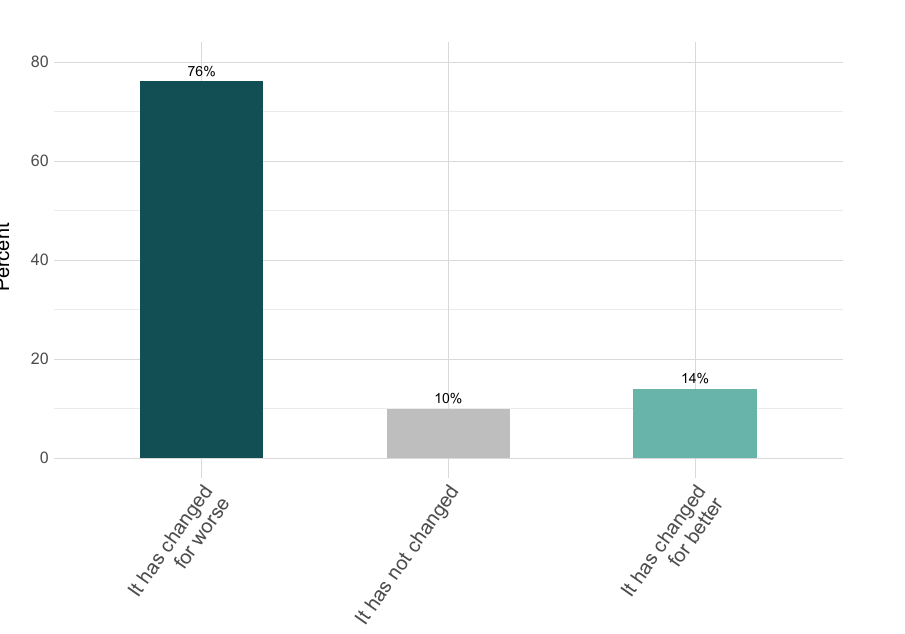
Figure 4. Overall satisfaction with the PhD training before and during the pandemic. Answers including “very” and “somewhat” for both “satisfied” and “dissatisfied” were collapsed.